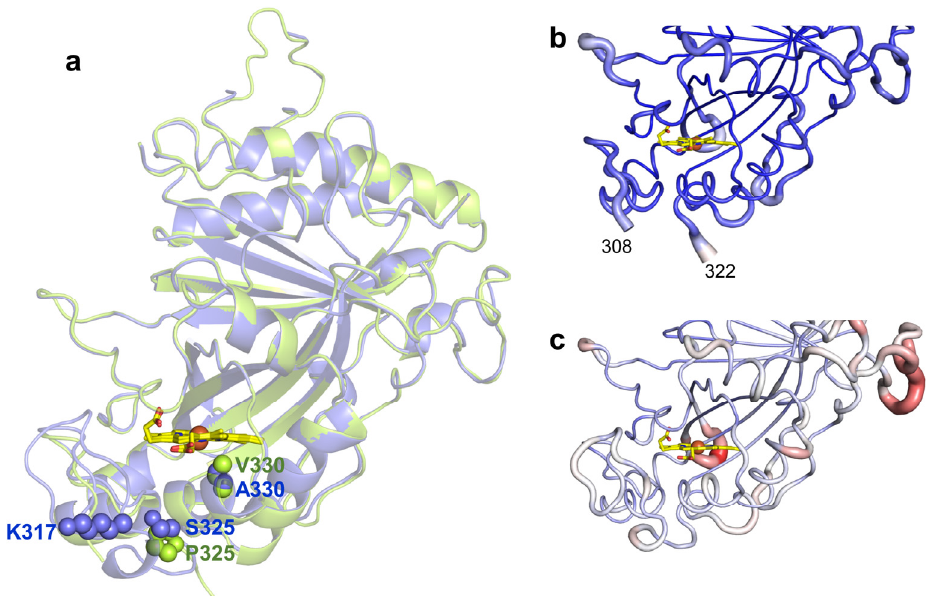
Figure 2. ( a ) Transparent secondary structure cartoon of superimposed wild type (blue) and 5G5 (green). The mutations P325 and V330 in 5G5 are shown as green spheres, and their homologs in the wild type as blue spheres. K317 is shown as blue spheres in the wild type and E317 is not visible in 5G5, and therefore is not represented. The heme is represented as sticks, with carbon, oxygen and nitrogen atoms colored as yellow, red and blue, respectively. The iron is shown as a brown sphere. Cartoon representation of the main-chain 5G5 ( b ) and wild-type ( c ) structures with thickness proportional to a.d.p. values, color coded from blue (21 Å 2 ) to red (126 Å 2 ). The full length enzymes contain 416 residues but the refined models consist of polypeptide chains with 349–354 amino acids; the first 45 residues, TAT signal, were deleted and the residues 46–55 (N-terminal) and 415–416 (C-terminal) are not visible in the electron density maps. A long loop region containing 32 residues (107–138) has high a.d.p.s, 55.4–109.8 Å 2 , and five residues (112–116) could not be modeled in the wild type due to lack of electron density. Additionally, the region 309–321 (boxed) becomes more flexible during evolution and is not visible in the electron density maps of 5G5 in chains A–C ( b ); in chain D, the missing region is between residues 317 and 321.